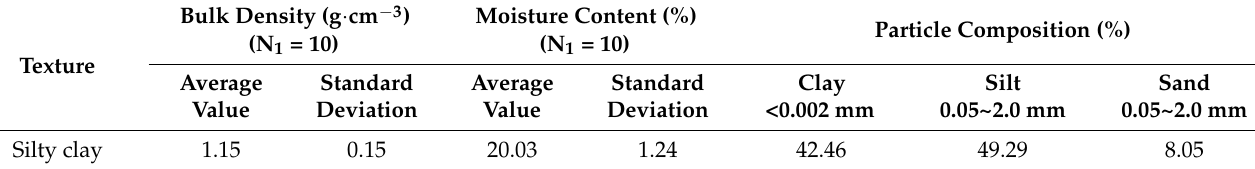
Table 2. Bulk density of paddy soil in the plough layer.